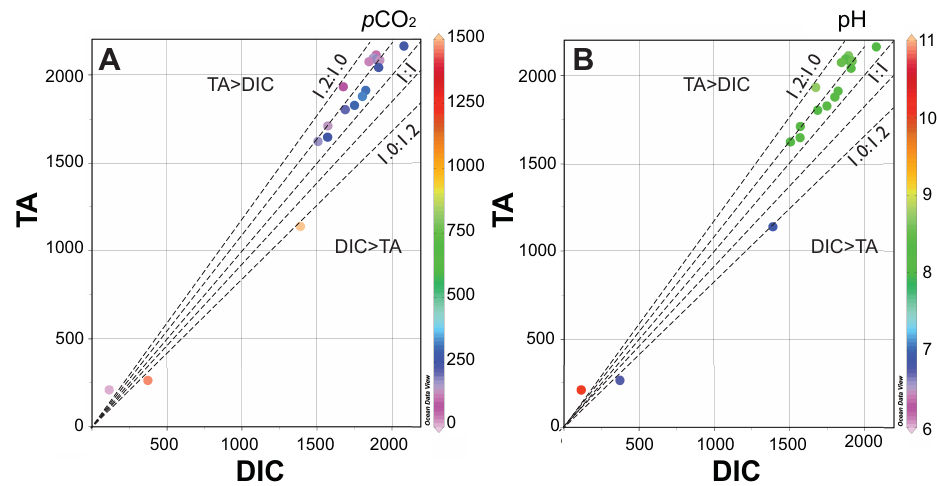
Figure 10. Scatter plots of TA and DIC against p CO 2 (µatm; panel a ) and pH (panel b ) for below-ice interface melt water sampled during the 2010 and 2011 ICESCAPE cruises in the western Arctic Ocean. The trend lines of TA:DIC ratios from 1 . 2 : 1 . 0 to 1 . 0 : 1 . 2 are